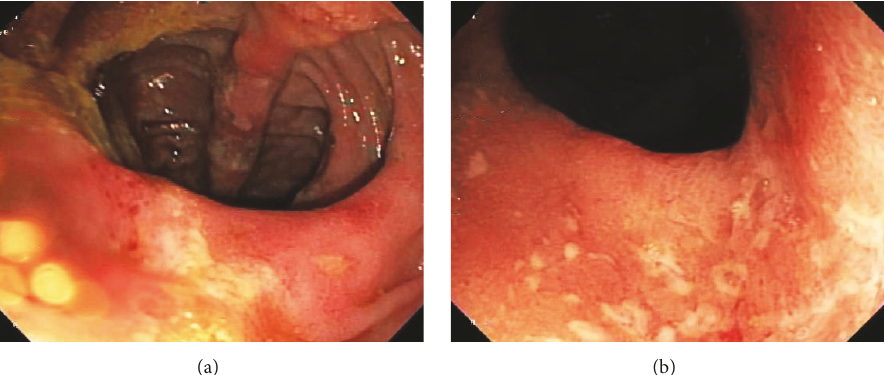
Figure4:(a)PouchoscopyshowsulcerationandmildinflammationintheJ-pouch.(b)Pouchoscopyshowsulcerationandmildinflammation in the terminal ileum proximal to the J-pouch.